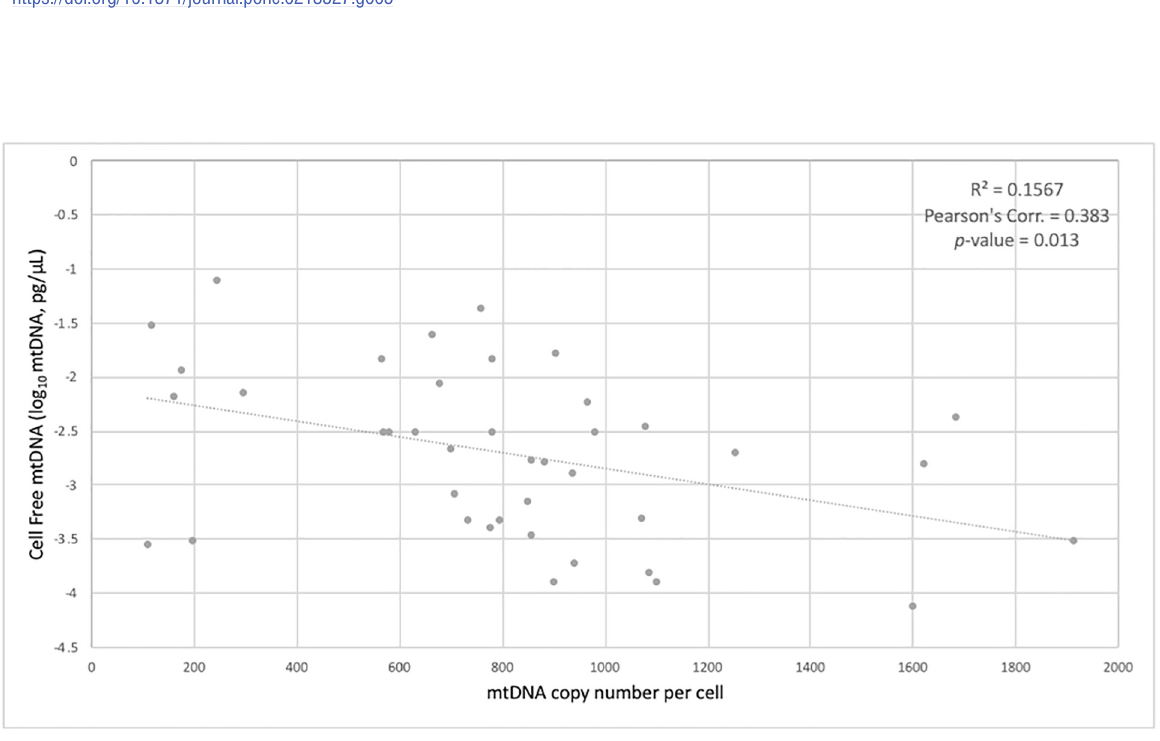
Fig 6. Correlations between mitochondrial indices. Pearson’s correlations showing significant relationships between cell-free mitochondrial DNA levels and mitochondrial DNA copy number (p-value = 0.013).